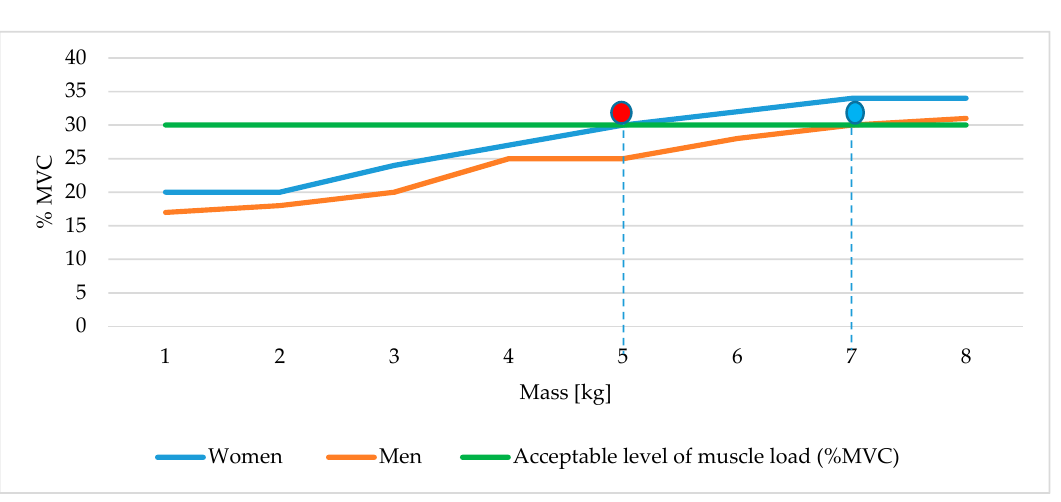
Figure 4. A frame-whisker chart of load distribution in the forearms generated by the examined farmers.